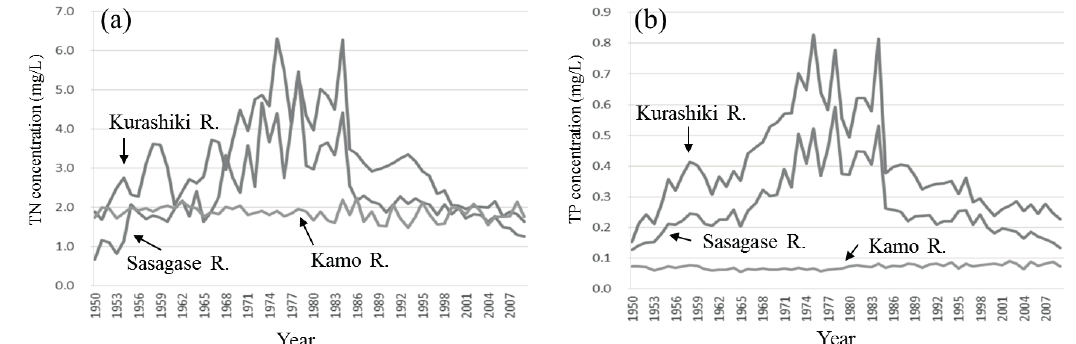
Fig. 3 Estimated annual mean concentrations of (a) TN and (b)